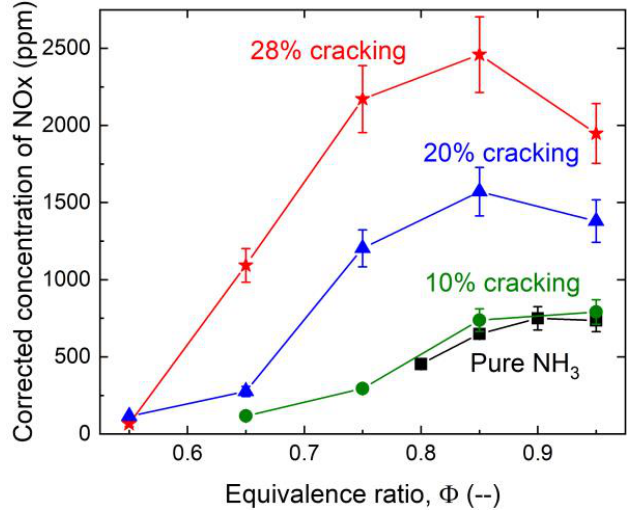
Figure 7. Corrected concentration of NOx (NO + NO 2 ), [NOx] corr , as a function of the equivalence ratio, Φ , for pure ammonia, ammonia at 10% cracking, ammonia at 20% cracking, and ammonia at 28% cracking flames.